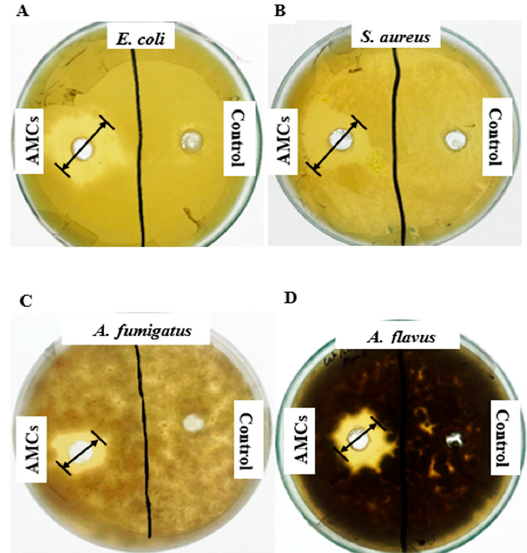
Figure 1. Antimicrobial activity of L. coryniformis BCH-4 ethyl acetate extracted antimicrobial compounds (AMCs) after 16 h of incubation for antibacterial and 48 h of incubation for antifungal activity. ( A ) E. coli (Gram-negative shiga toxin producing bacterial strain); ( B ) S. aureus (Gram-positive multi-drug resistant bacterial strain); ( C ) A. fumigatus (Saprotrophic filamentous fungus) ( D ) A. flavus (Aflatoxigenic filamentous fungus). de Man, Rogosa and Sharpe (MRS) broth was used as a negative control and the well diameter was 8 mm.